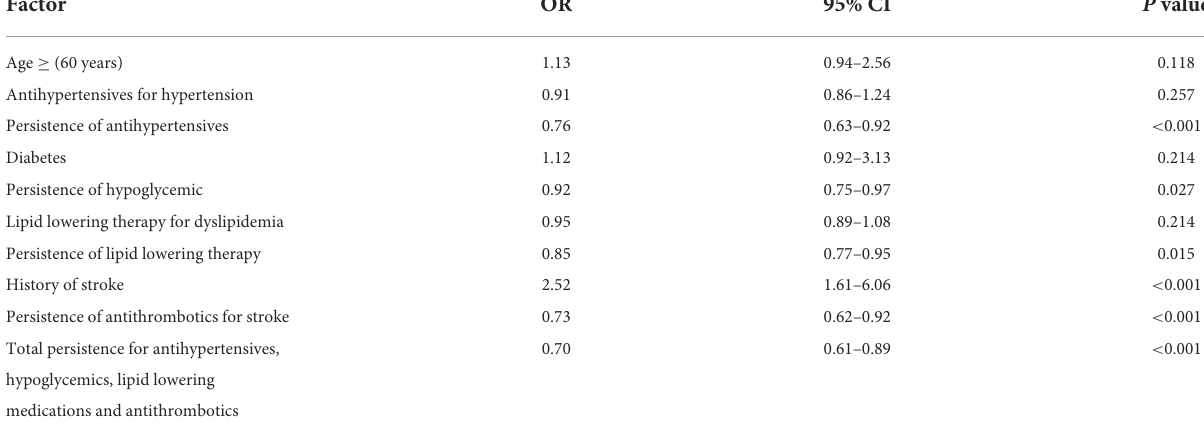
TABLE 6 Multivariable regression analysis of risk factors for total new composite vascular events during follow-up.